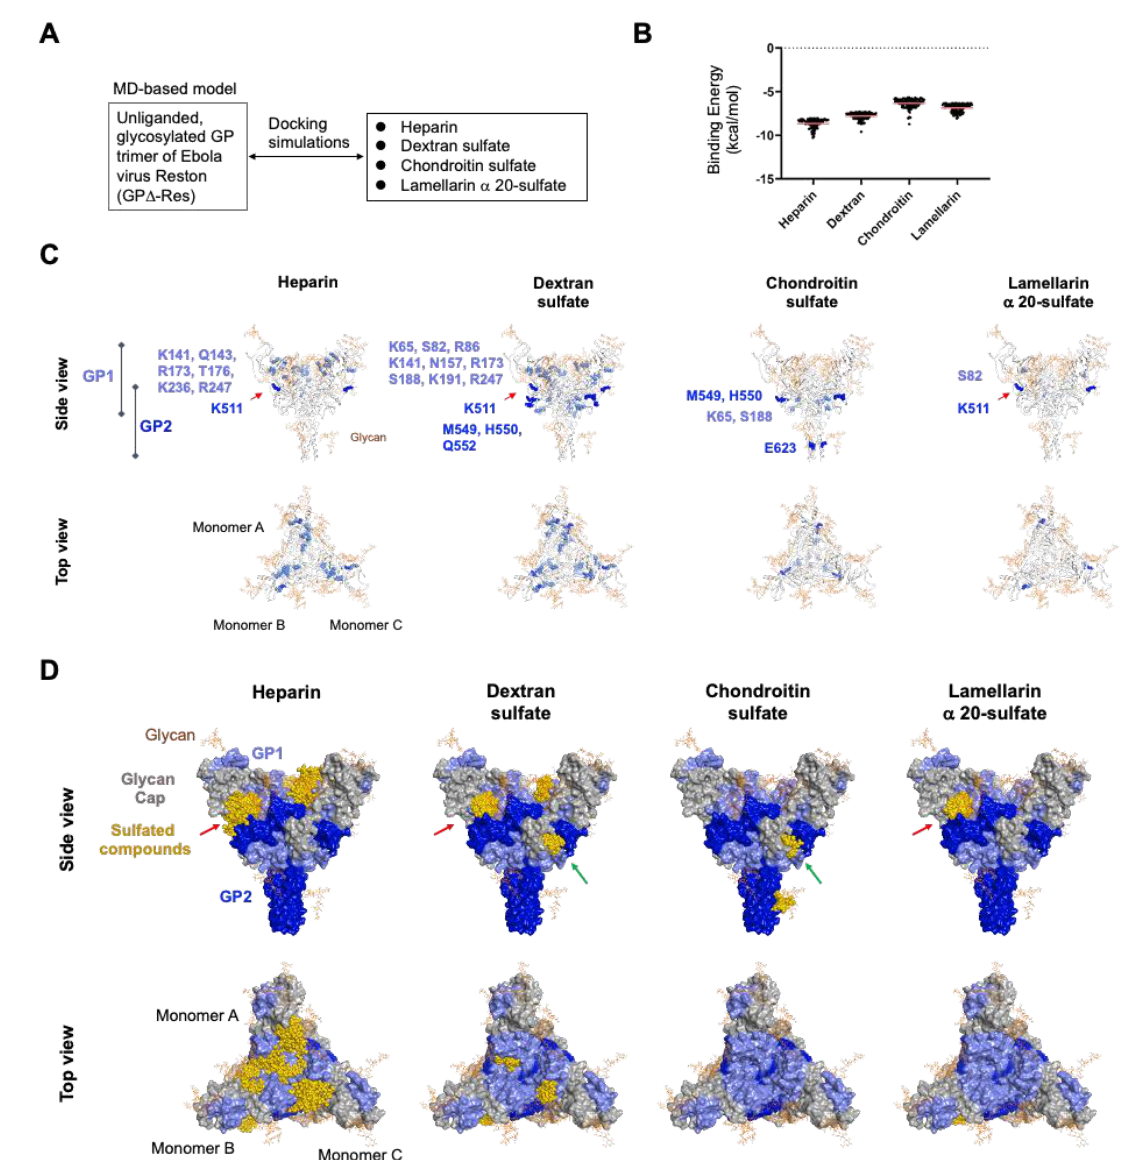
Figure 8. Characterization of possible binding modes of sulfated compounds on the Reston Ebola virus glycoprotein. Docking simulations of sulfated compounds to the Ebola virus GP Δ -Res structure at 100 ns of MD simulation were performed using the Dock application in MOE. ( A ) Overview of docking simulations. ( B ) Distribution of binding energies of the top 100 binding poses. Binding free energies were calculated for each docking pose using the Dock tool in MOE. Red lines indicate mean values. ( C ) Distribution of glycoprotein residues for binding with sulfated compounds. Amino acid residues interacting noncovalently with sulfated compounds were identified with the 100 docking poses using the Contact Analysis tool in MOE. Residues that were involved in the noncovalent interactions more than 10 times in the 100 docking poses are highlighted in different colors. Light blue and blue spheres indicate residues in the GP1 and GP2 subunits, respectively. ( D ) Docking poses of sulfated compounds. Dark yellow spheres indicate atoms of compounds noncovalently bound with the glycoprotein residues in ( C ). Red arrows indicate a binding site common to heparin, dextran sulfate, and lamellarin α 20-sulfate. Green arrows indicate a binding site common to dextran sulfate and chondroitin sulfate, which was found to be identical to a binding site of the approved anti-Ebola virus drugs